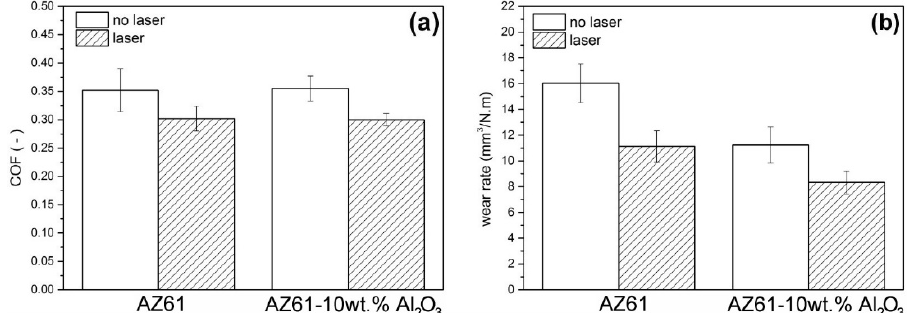
Figure 6. Tribological properties of investigated materials: ( a ) coefficient of friction and ( b ) specific wear rate.